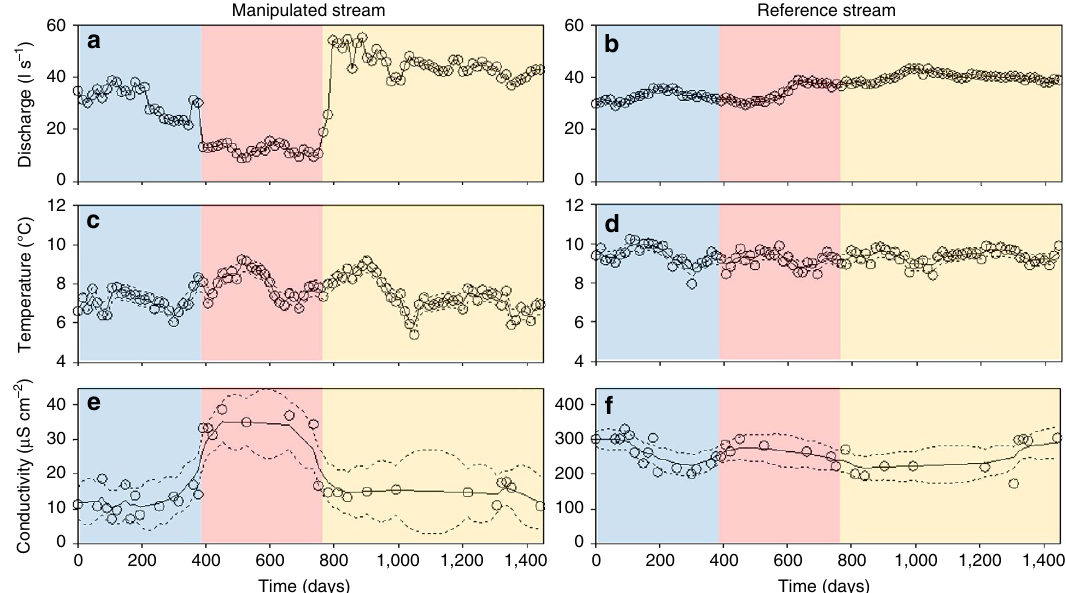
Figure 1 | Environmental time series. Time series (open dots), smoothed-state estimates (solid lines) and state 95% confidence level (dotted lines) of discharge ( a , b ), water temperature ( c , d ), and conductivity ( e , f ) for the downstream reach of the manipulated stream and the reference stream. Blue, red and yellow regions indicate base flow, flow alteration and flow recovery periods,